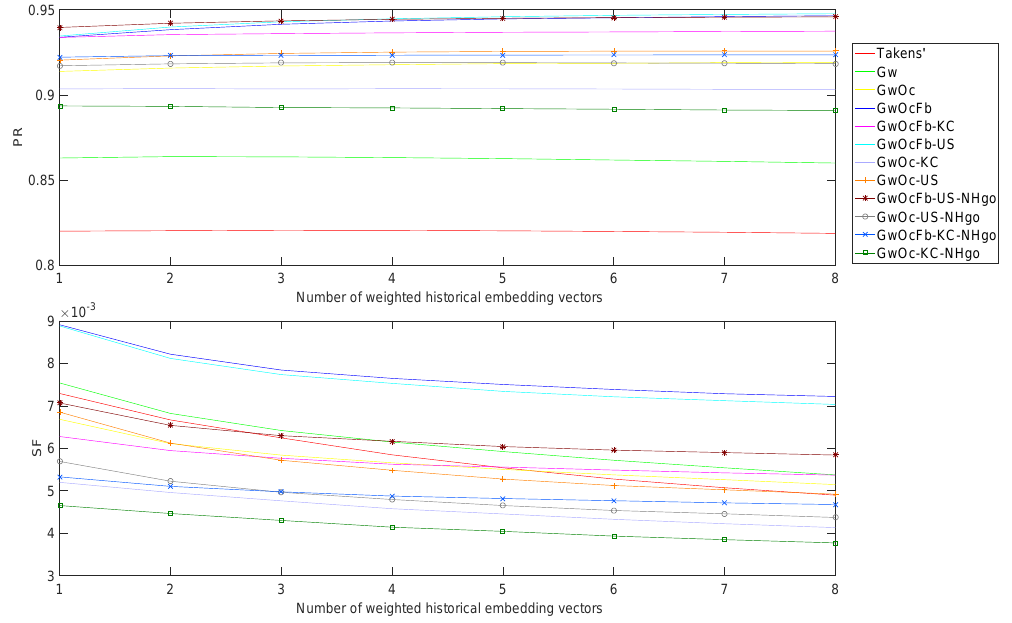
Figure 10. Influence of weighted historical embedding vector number (left hip joint data in the sagittal